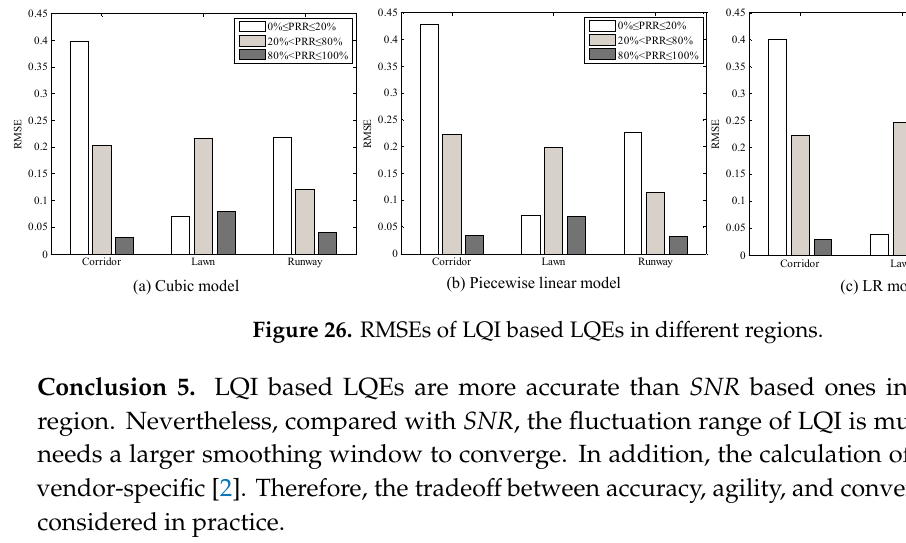
Figure 25. RMSEs of SNR based LQEs in different regions.